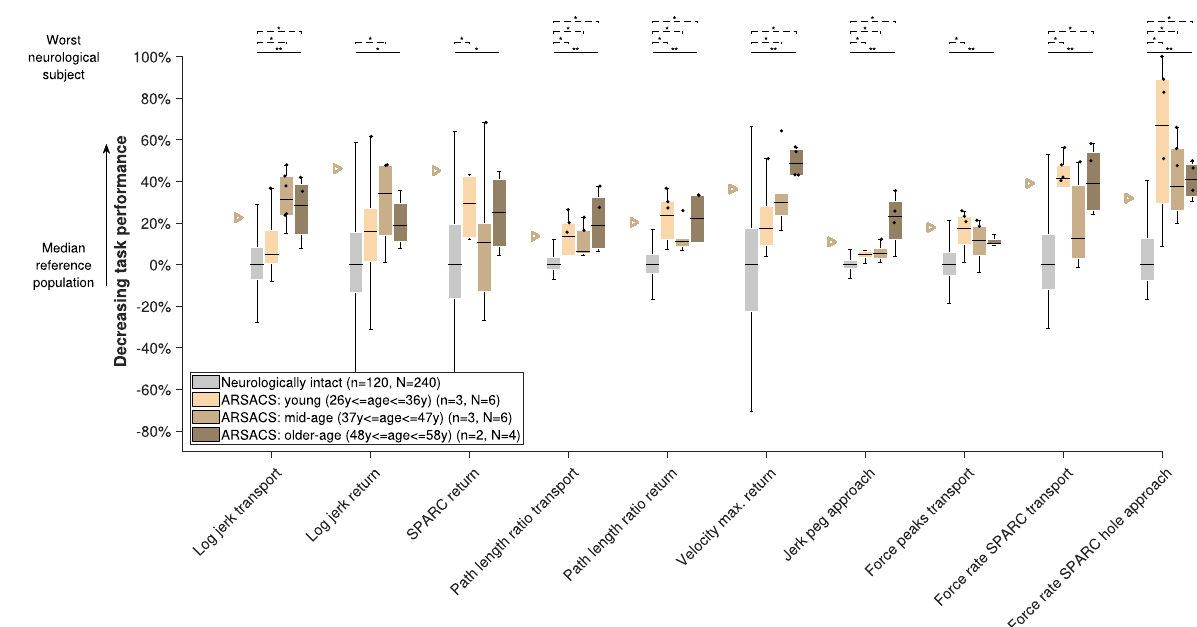
Fig. 6 Sensitivity of metrics to disability severity in ARSACS subjects. See Fig. 4 for a detailed